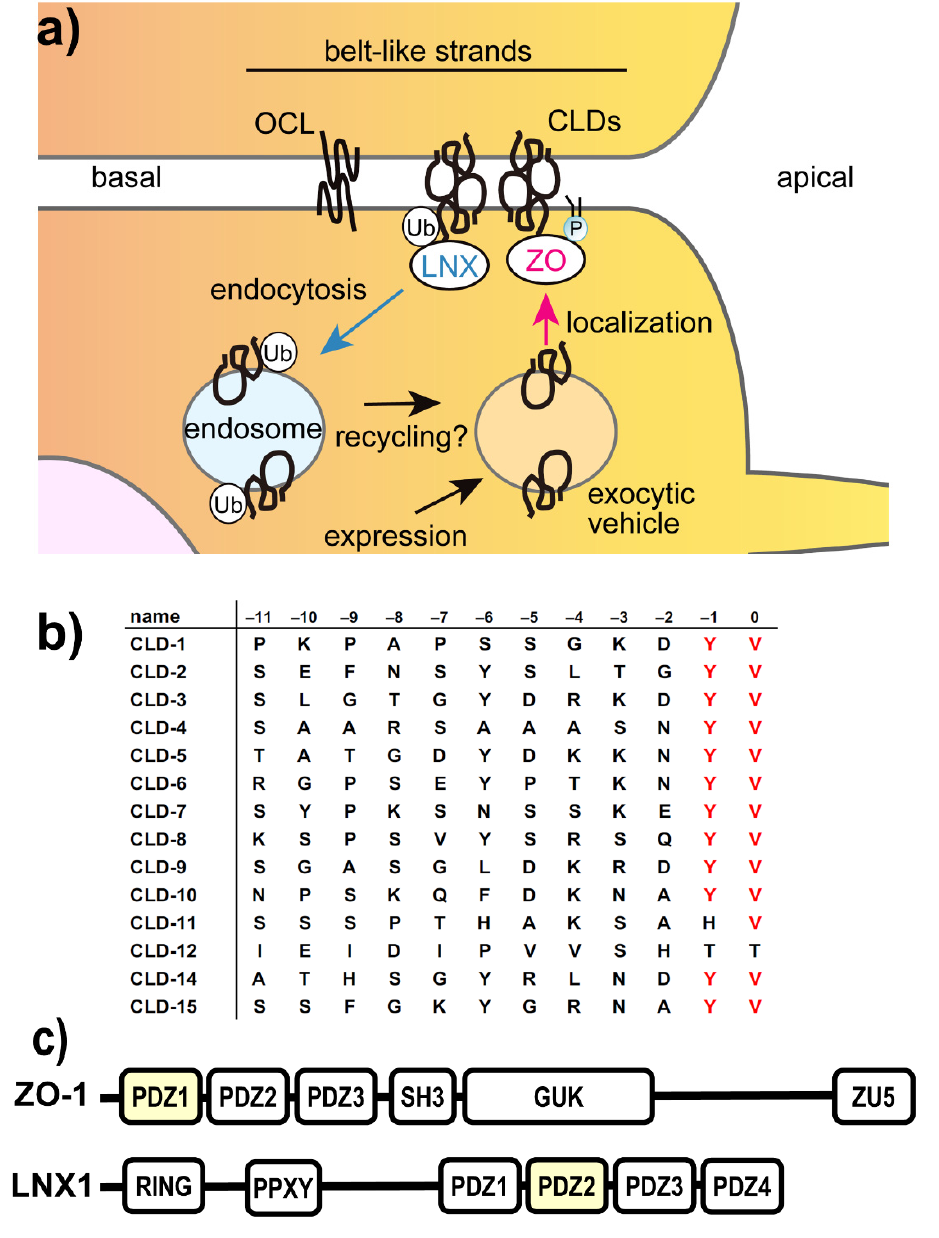
Figure 1. Components of tight junction complexes and the key molecular interactions among regulatory proteins and claudins. ( a ) Schematic overview of dynamic equilibrium between biogenesis and internalization of tight junction (TJ) components, claudins (CLDs), and occludin (OCL), associated with either ZO-1/2/3 (ZO) proteins or ligand-of-NUMB X1 (LNX). P denotes phosphatidyl-inositol phosphates, and Ub denotes ubiquitin. ( b ) Amino acid sequences of PDZ-binding motifs at the C-termini of human CLDs. The conserved C-terminal residues are colored in red. ( c ) Domain architectures of ZO-1 and LNX1 proteins. RING; RING domain, PDZ, PDZ domain; PPXY, NUMB binding motif; SH3, Src homology 3 domain; GUK, guanylate kinase domain; ZU5, ZO-1, and Unc5 homology domain. PDZ domains responsible for CLD interaction are colored yellow.